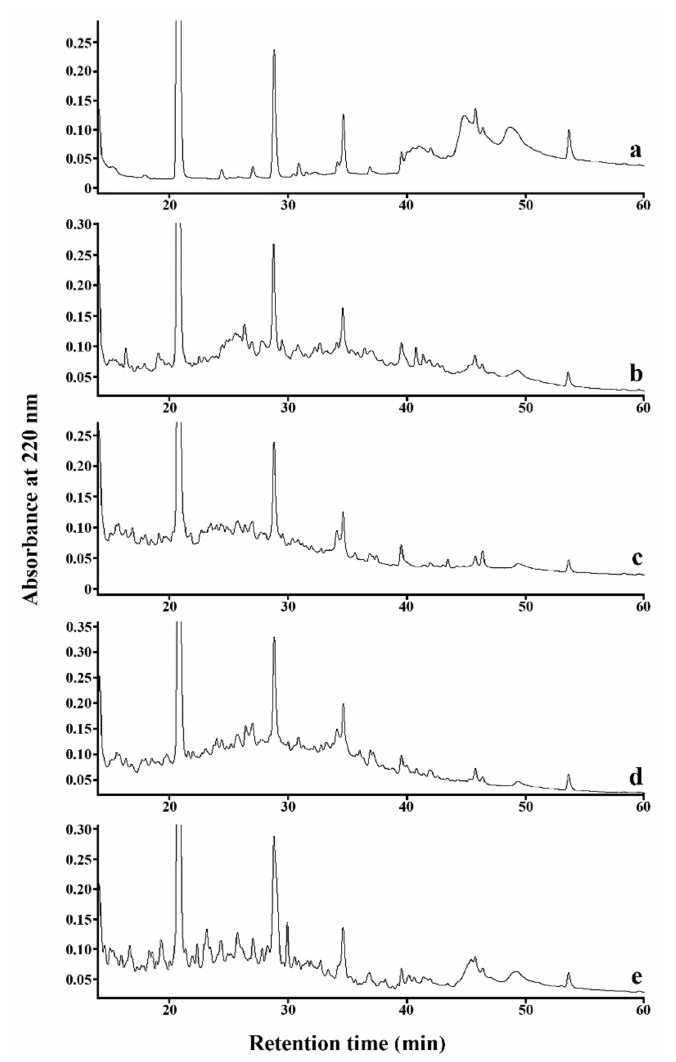
Figure 1. RP-HPLC (Reversed-Phase High Performance Liquid Chromatography) chromatograms of 0-soy protein concentrate (SPC) ( a ), B-SPC ( b ), F-SPC ( c ), P-SPC ( d ), and PK-SPC ( e ). Retention time range displayed in the Figure is between 14th and 60th minute. Chromatograms were acquired at λ = 220 nm as recommended by Visser et al. [21]. Abbreviations: 0-SPC-soy protein concentrate, B-SPC, F-SPC, P-SPC and PK-SPC: bromelain-, ficin-, papain-, and proteinase K-soybean